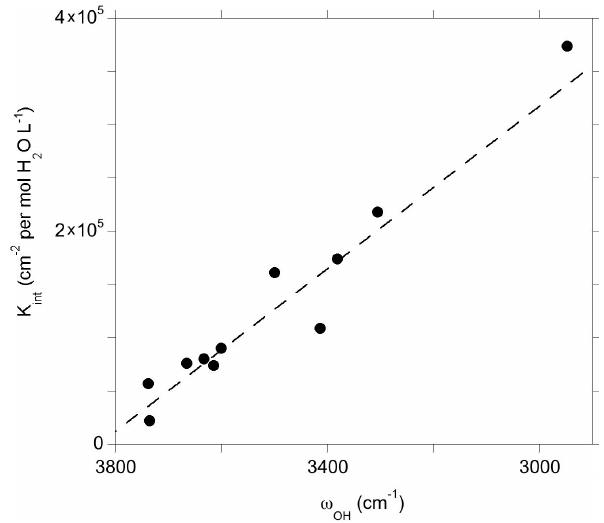
Figure 9. Theoretical OH-stretching frequencies of defect models vs. OH bond lengths. Figure 10. Theoretical integrated molar absorption coefficients ( K int ) of defect models displaying a single OH group as a function of the corresponding OH-stretching frequency ( ω OH ). The dashed line corresponds to the general trend of Balan et al. (2008) shifted by 50cm − 1 : K int = 382 ( 3832 − ω OH ) (see